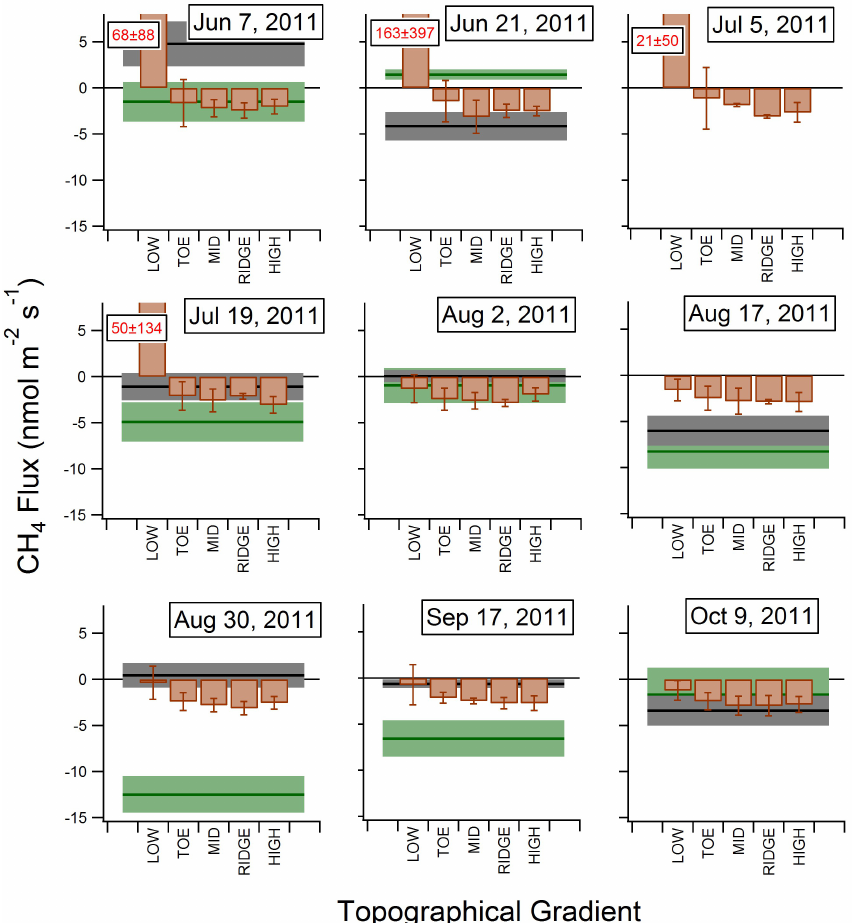
Fig. 9. Bar graph of fluxes calculated from chamber measurements (brown), and EC measurements during the daytime (green) between 08:00 and 19:00 and nighttime (black) between 22:00 and 07:00 for the three days around the chamber measurement. The error bars indicate the standard deviation of the mean within the averaging period for the EC fluxes, or across the sites for the chamber fluxes. No EC measurements were made on 5